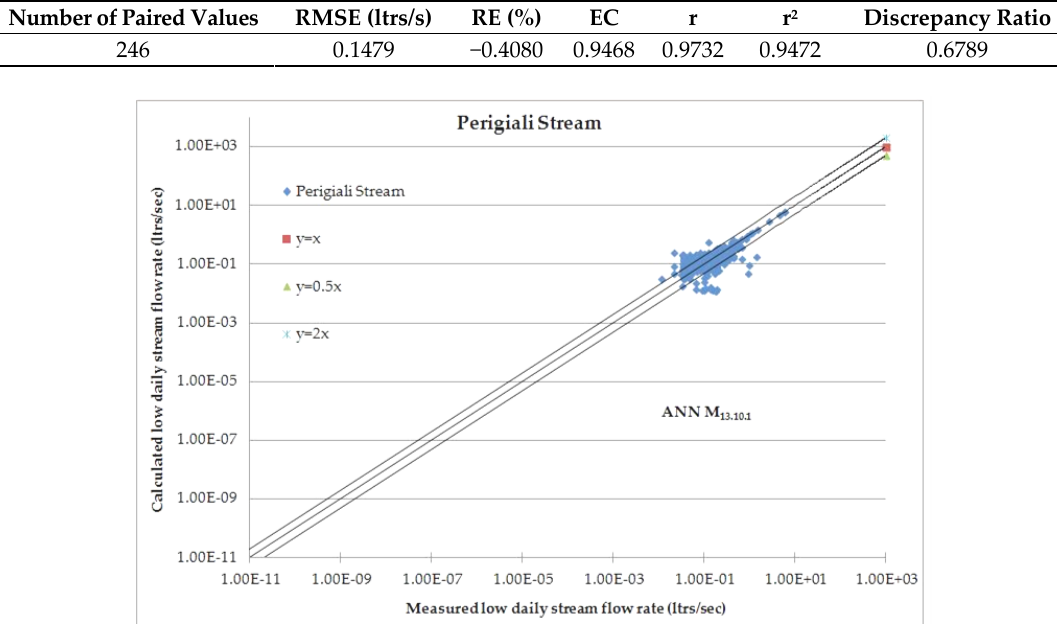
Table 1. Statistical criteria values of Perigiali Stream (ANN M 13.10.1 ).